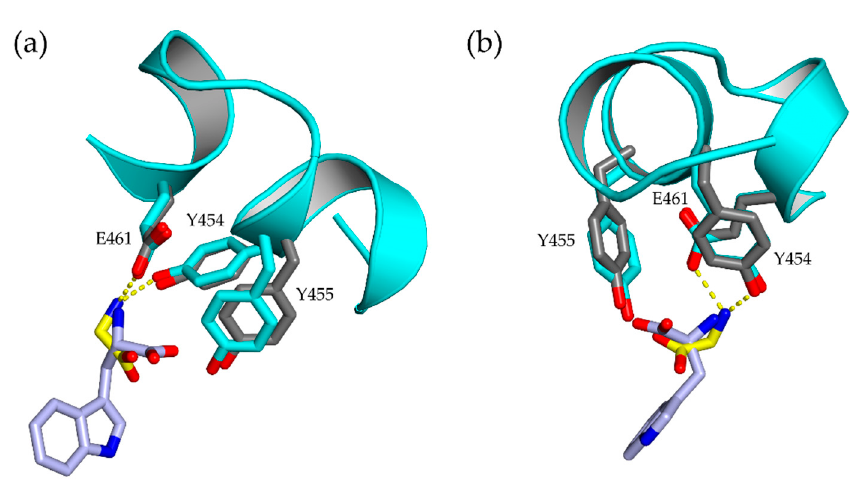
Figure 2. Active sites of N His -Thal-RebH5 (1) and Trp-Thal (6H44). Alignment of the bound substrate tryptophan (light blue) of Trp-Thal (6H44) (gray) and the active site of N His -Thal-RebH5 ( 1 ) chain A (cyan) where a glycine (yellow) could be modeled, which superposes with the backbone of the tryptophan. In the figure, the structure in ( a ) is rotated relative to that in ( b ).